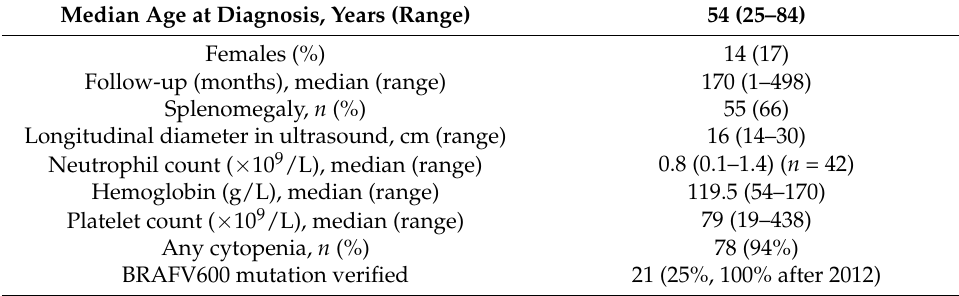
Table 1. Patient characteristics ( n = 83).